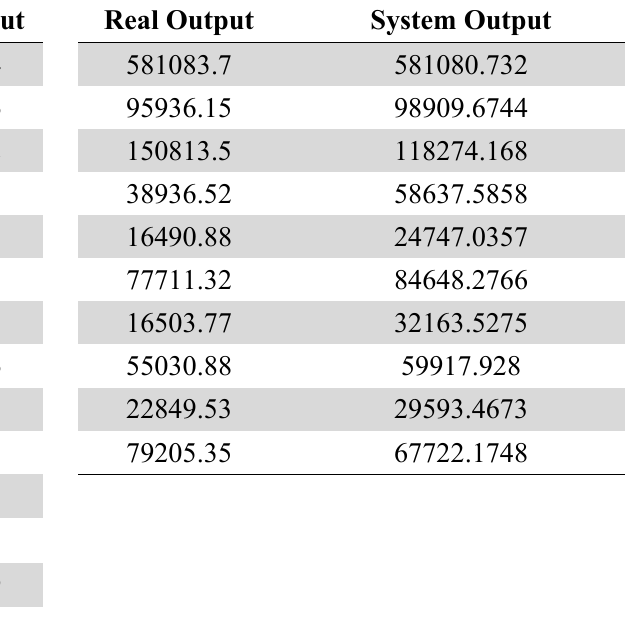
Comparing the Outputs of Market Risk Eval- uation Model with Real Outputs